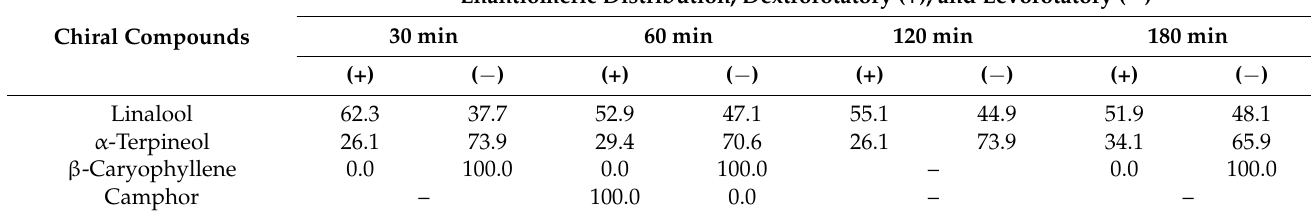
Table 9. Enantiomeric distributions of chiral terpenoids present in wintergreen essential oil based on distillation time; “–” indicates not detected; “+” indicates dextrorotatory.